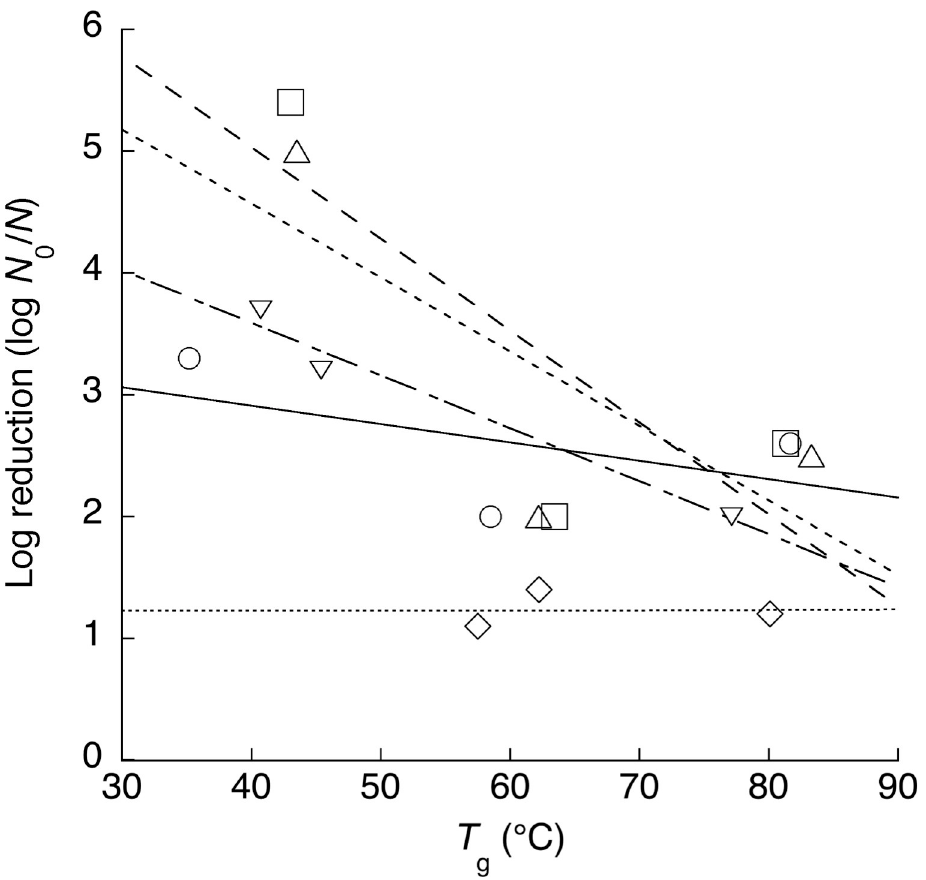
Fig 4. Relationship between glass transition temperature ( T g ) and inactivation effect (log reductions) of Salmonella Typhimurium ( � , solid line), S . Chester ( 4 , dashed line), S . Oranienburg ( □ , dotted line), S . Stanley ( � , fine dotted line), and S . Enteritidis ( 5 , dot dashed